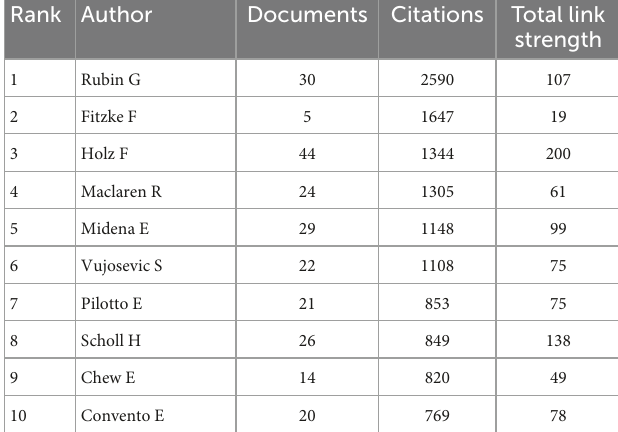
TABLE 2 The top 10 authors in the field of microperimetry (rank by